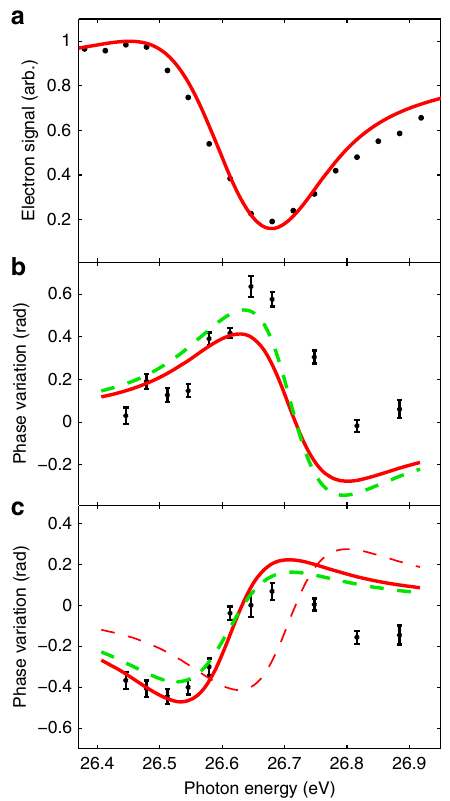
Figure 3 | Intensity and phase variation of the photoionization amplitude. ( a ) Photoionization signal as a function of harmonic 17 photon energy. The black symbols denote experimental results and the red curve calculations. Phase variation of sideband 16 ( b ) and sideband 18 ( c ) as a function of the energy of harmonic 17. The theoretical results are indicated by the red solid line, whereas the experimental results are shown by the black symbols. The error bars represent the statistical uncertainty (1 s.d.) of the phase determined by fitting sideband oscillations. The thin dashed red line in c is the opposite of the red line for sideband 16, which is close to the corresponding results for sideband 18, apart from an energy shift. This energy shift can be attributed to the influence of the partly ionized medium on the probe laser wavelength. The green dashed lines correspond to calculations including the processes indicated with dashed arrows in Fig. 1a. The agreement between theory and experiment is not significantly improved by taking these processes into